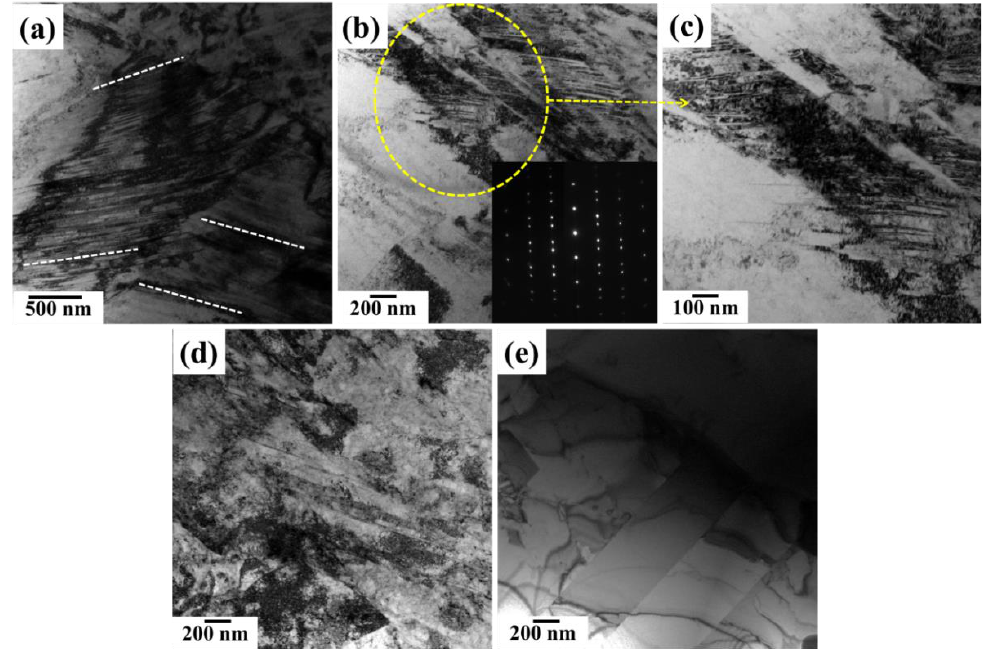
Figure 5. TEM representative micrographs of deformed specimens of low-density steel at various strain rates of ( a – c ) at 4900 s − 1 ; ( d ) 5950 s − 1 ; ( e ) as-received specimen. strain rates of ( a – c ) at 4900 s − 1 ; ( d ) 5950 s − 1 ; ( e ) as-received